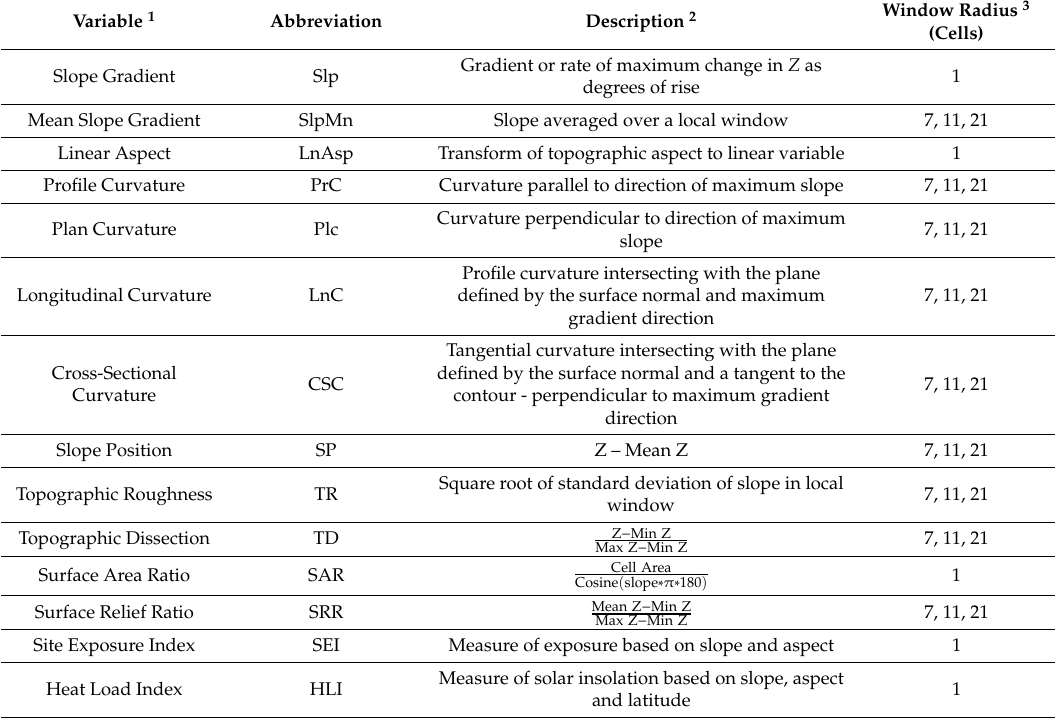
Table 2. Description of terrain variables used in study. Abbreviations defined in this table will be used throughout the